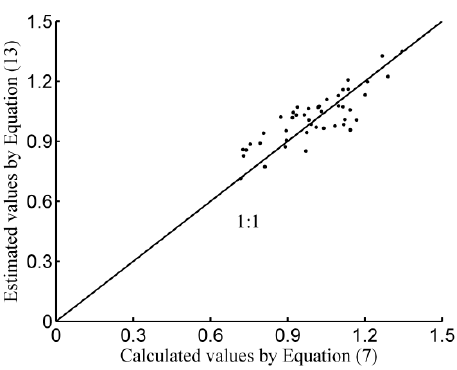
Figure 6. Calculated normalization factor from Equation (7) and estimated values from Equation (13).